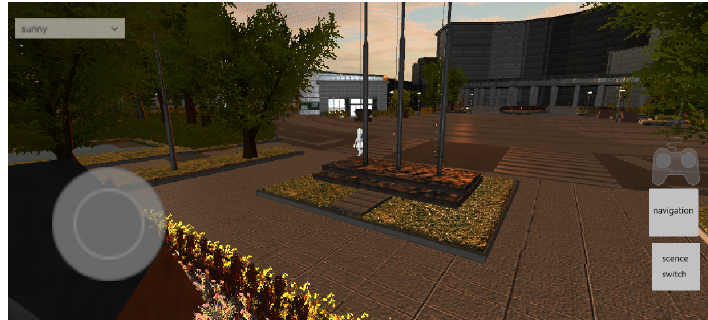
Figure 7. VR character action.